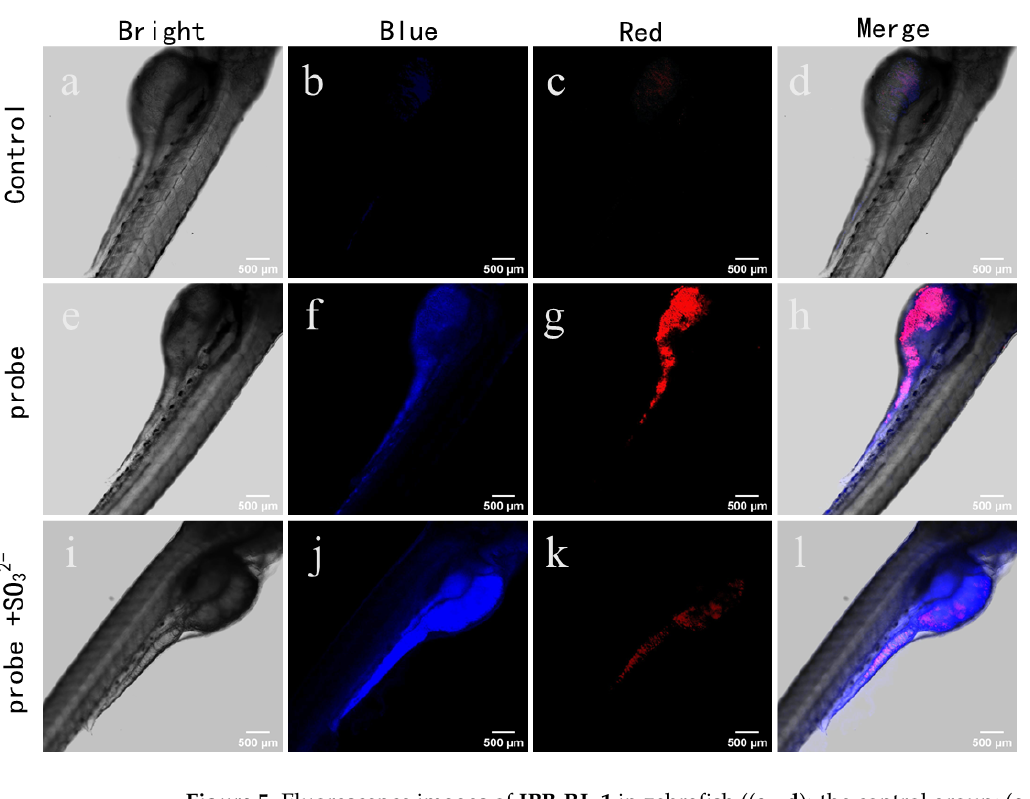
Figure 4. ( a ) Fluorescence images of IPB-RL-1 in SKOV − 3 cells (blue channel: 420 − 520 nm; λ ex : 405 nm). ( b ) Fluorescence images of Mito-Tracker Red CMXRos (red channel: 570 − 620 nm; λ ex : 561 nm). ( c ) Merged images of ( a , b ). ( d ) Images of co − location (co − location coefficient 0.91). ( e ) Fluorescence intensity of red channel and blue channel changes, respectively (λ ex : 405 nm).